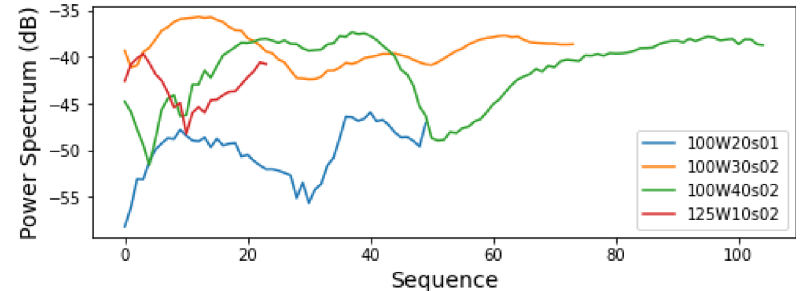
Figure 7. Power spectrum analysis of scattered echo signal with low ultrasonic dose irradiation.